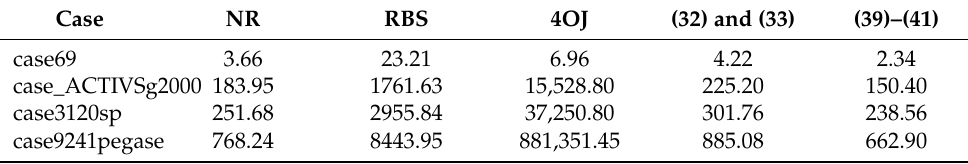
Table 11. Solution times (ms) for well-conditioned cases with reactive limits.